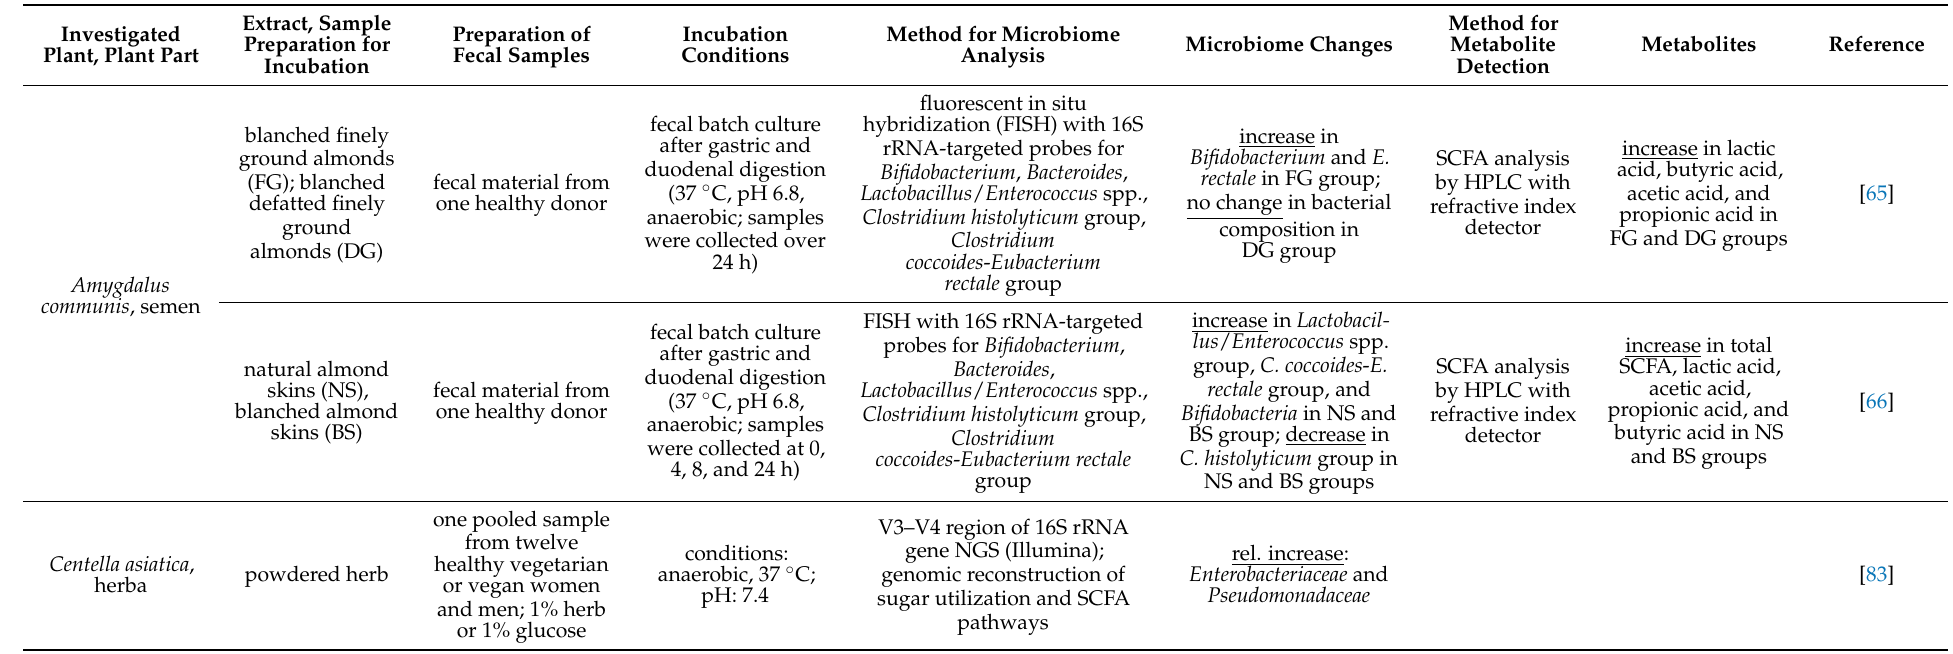
Table 2. In vitro studies of the herb–gut microbiome interactions of medicinal plants used for mental